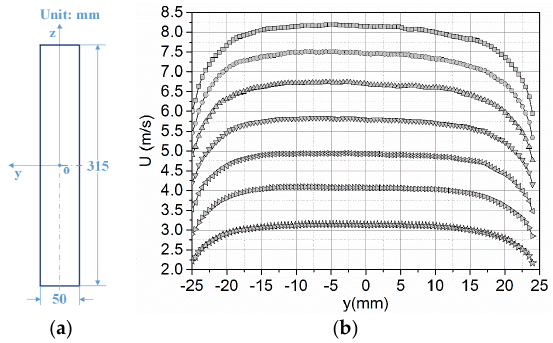
Figure 15. Cross-sectional upstream flow velocity distributions in the test section of a water tunnel: ( a ) cross-section dimensions of the test segment; ( b ) velocity distributions at different upstream velocity